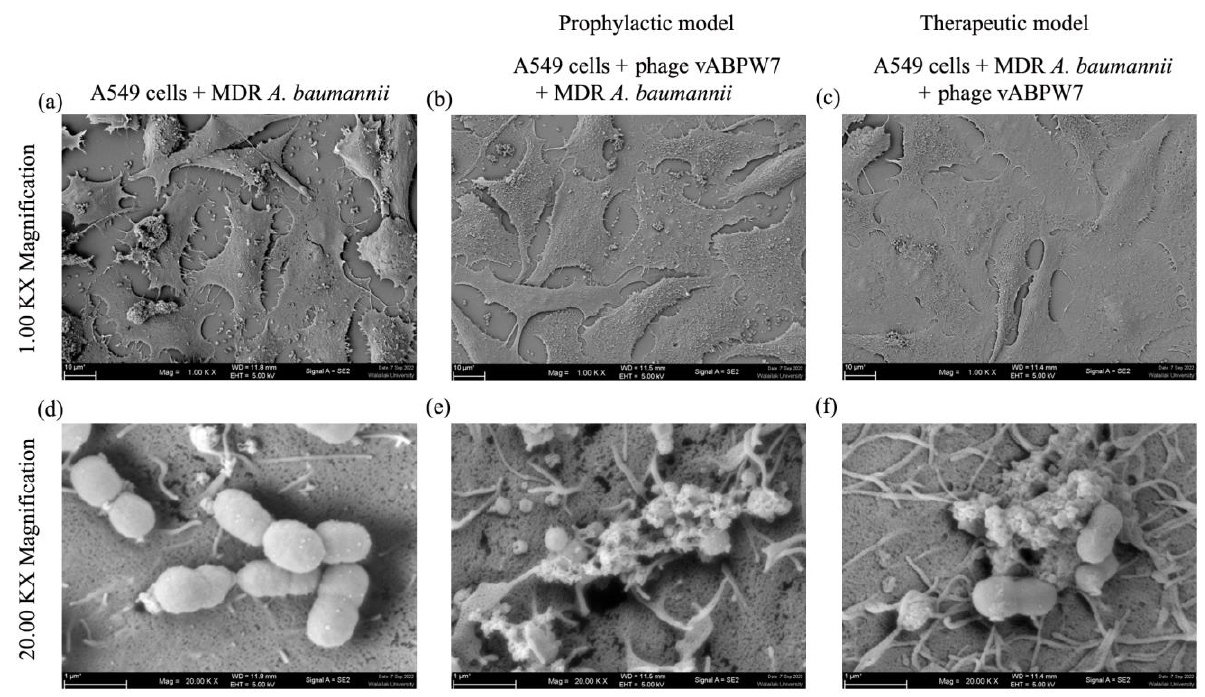
Figure 9. Ultrastructural analysis of MDR A. baumannii that attached to the cell surface of A549 cells under FE-SEM. ( a , d ) A549 cells incubated with only MDR A. baumannii. ( b , e ) A549 cells were treated with phage vABWU7 and then infected with MDR A. baumannii as a prophylactic application. ( c , f ) A549 cells were infected with MDR A. baumannii and then treated with phage vABWU7 as a therapeutic application. The cells were observed at magnifications of x1000 and x20,000.